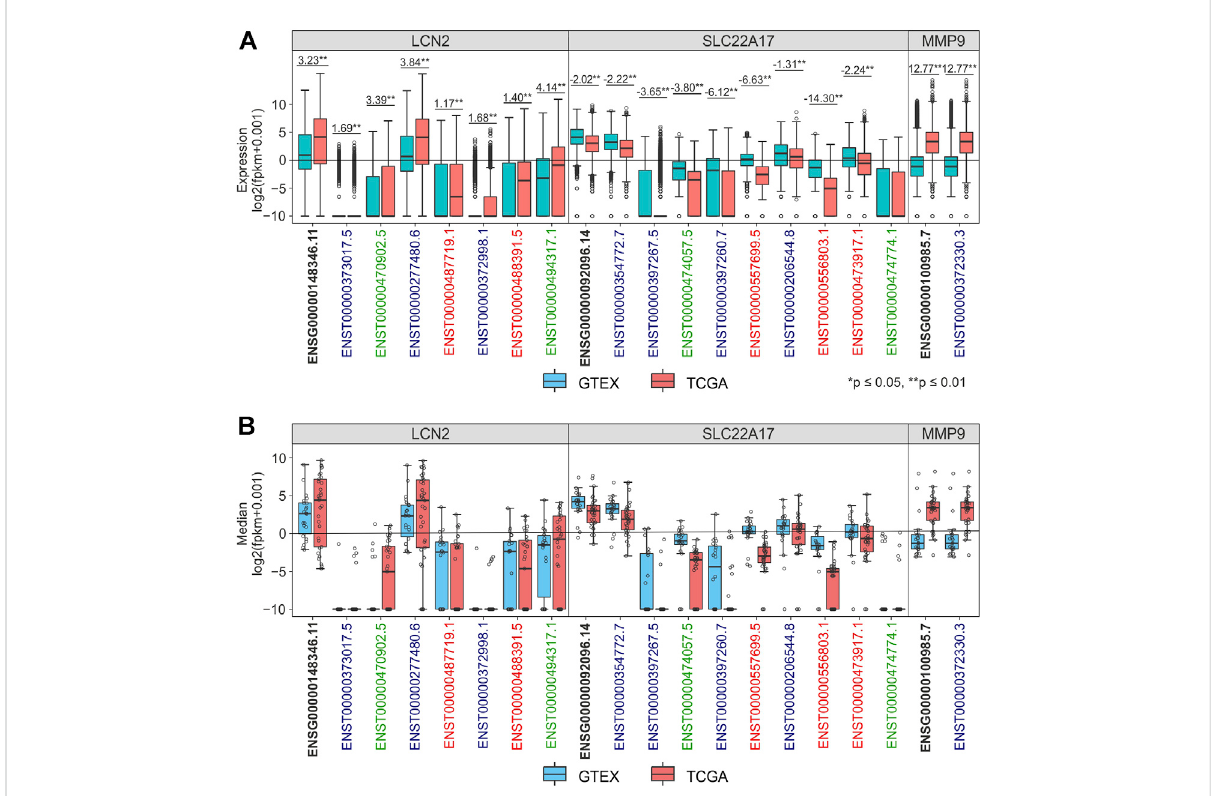
FIGURE 1 Differential analysis of LCN2 , SLC22A17 , and MMP9 expression levels in TCGA tumor and GTEx normal samples. (A) Expression levels of LCN2 , SLC22A17 , and MMP9 genes and isoforms in normal (blue) and tumor samples (red). Fold Change was reported for each comparing group. (B) Distribution of expression median values calculated for the gene and isoforms (empty circles) is shown for each tumor type and matched normal tissues. Black bold labels indicate the LCN2 , SLC22A17 , and MMP9 gene expression (ENSG), including all spliced transcripts (ENST). Coding isoforms: blue; non-coding isoforms: green; retained intron isoforms: